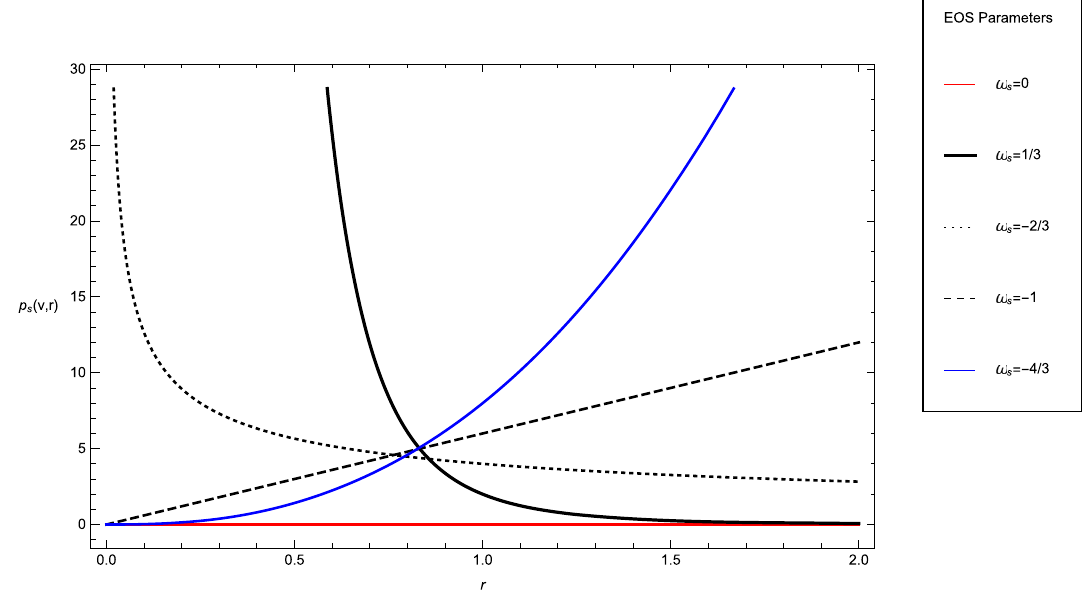
Fig. 5 Plot indicating the evolution of the pressure of the fluid distribution with respect to r , for each of the matter field